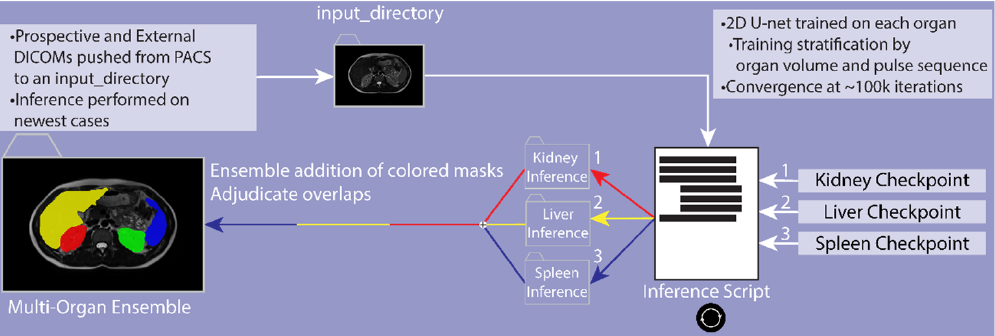
Figure 1. DICOMs of prospective and external cases are pushed to a root input directory from PACS. Checkpoints of each organ are then used to perform organ-specific inference. Once all inferences are complete, the algorithm combines the organs and adjudicates the model overlaps to create a multi-organ ensemble.